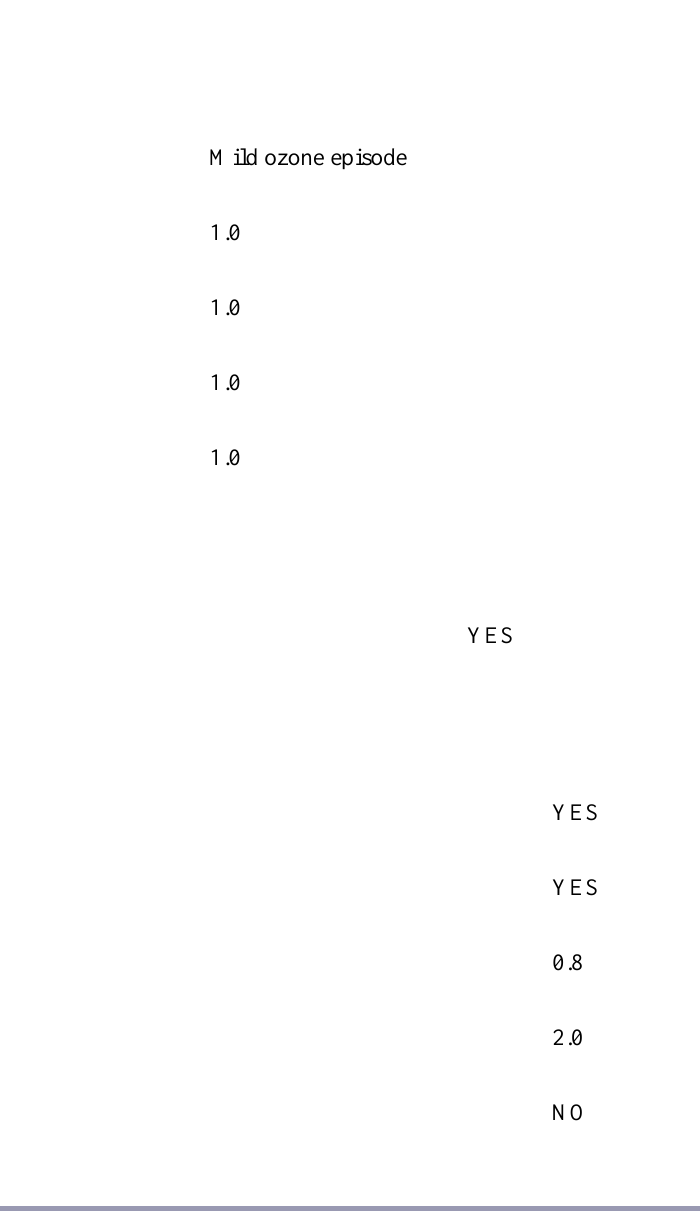
Table G. Species and habitats